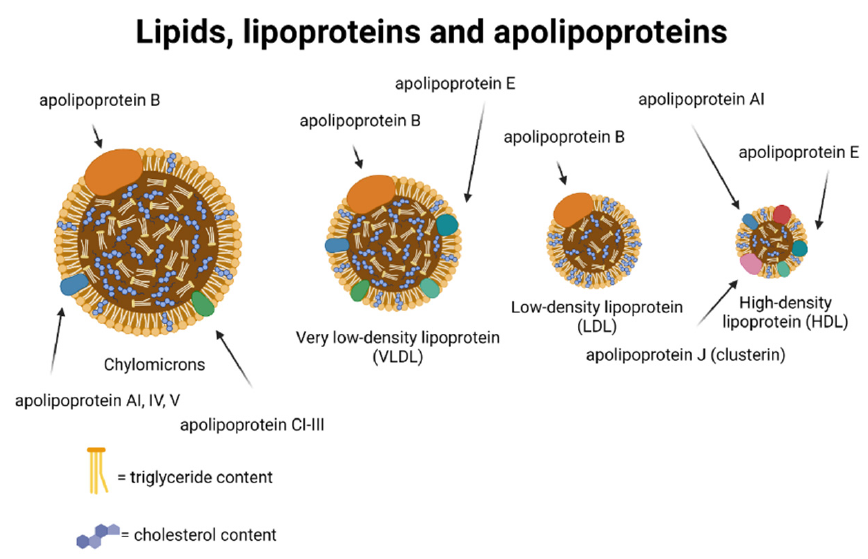
Figure 2. Illustration of plasma lipids, lipoproteins, and apolipoproteins. Note, only the apolipoproteins most relevant for this review are shown. Created with Biorender.com.